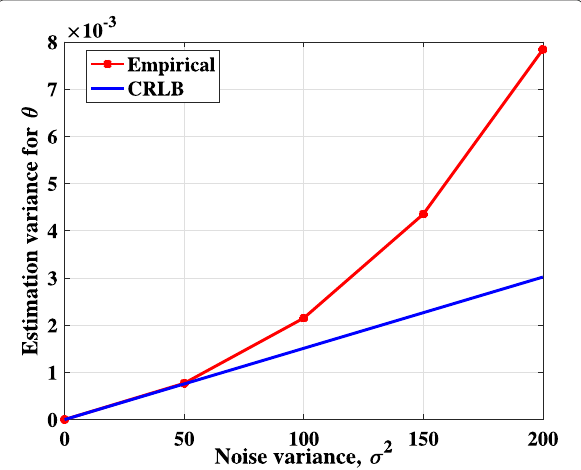
Fig. 5 Probability of detection versus probability of false alarm for N = I = 3 and b sp 0 = 10 3 ×